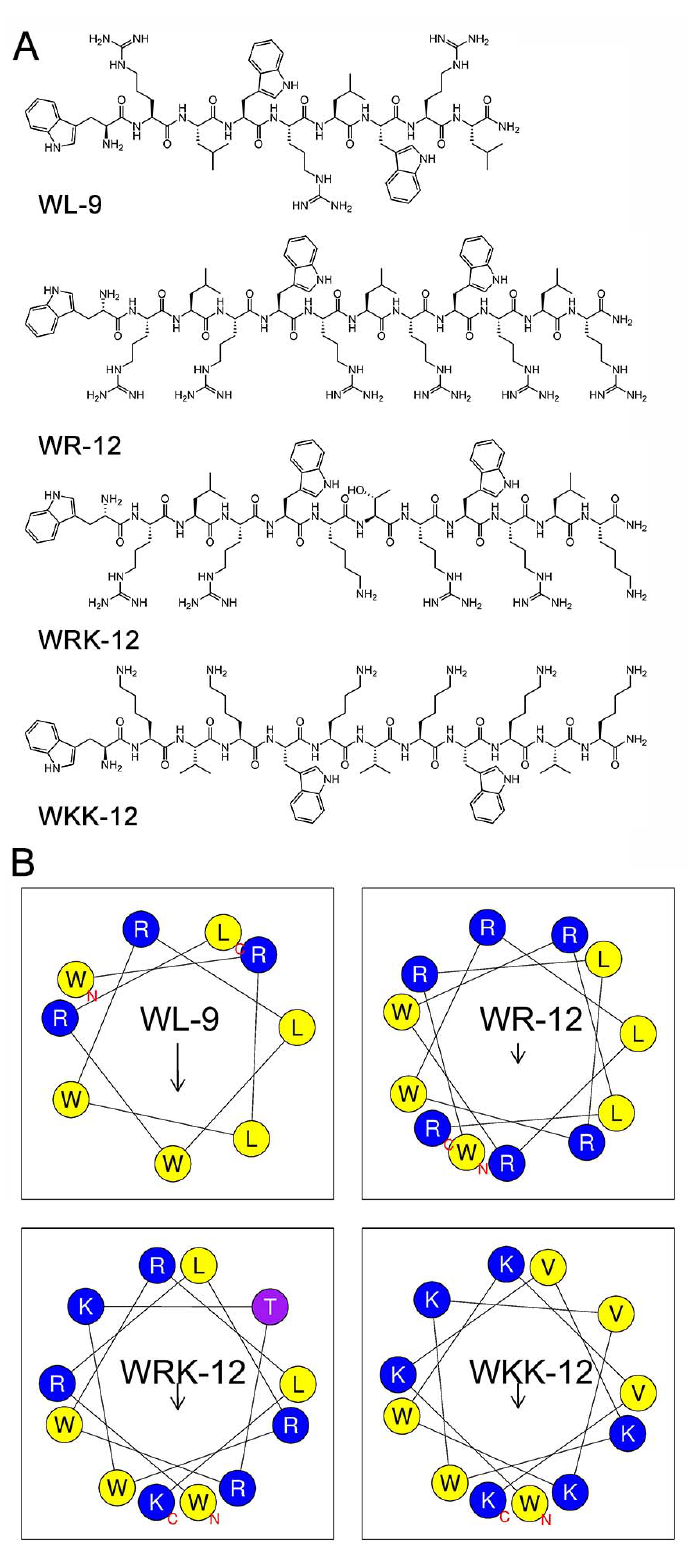
Figure 1. Design of tryptophan-rich amphiphilic antibacterial peptides. ( A ) Chemical structures of four active AMPs (WL-9, WR-12, WRK-12 and WKK-12). ( B ) Helical wheel projections of four AMPs. The potentially charged residues, hydrophobicity residues and uncharged residues were marked as blue, yellow and pink, respectively. The longer the arrow length, the greater the relative hydrophobic moments in the